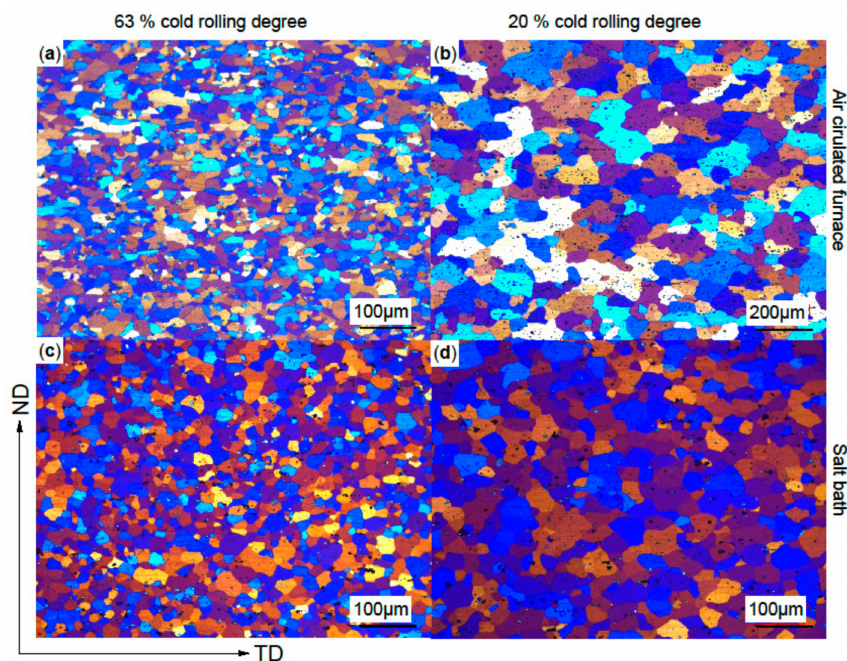
Figure 9. Light optical micrographs of typical microstructures for 63% ( a , c ) and 20% ( b , d ) cold rolling and soft annealing in an air-circulated furnace ( a , b ) and in a salt bath with subsequent water quenching ( c , d ). Please note the di ff erent scale for the air-circulated furnace heat treatment at 20% cold-rolling degree. Normal direction (ND), transversal direction